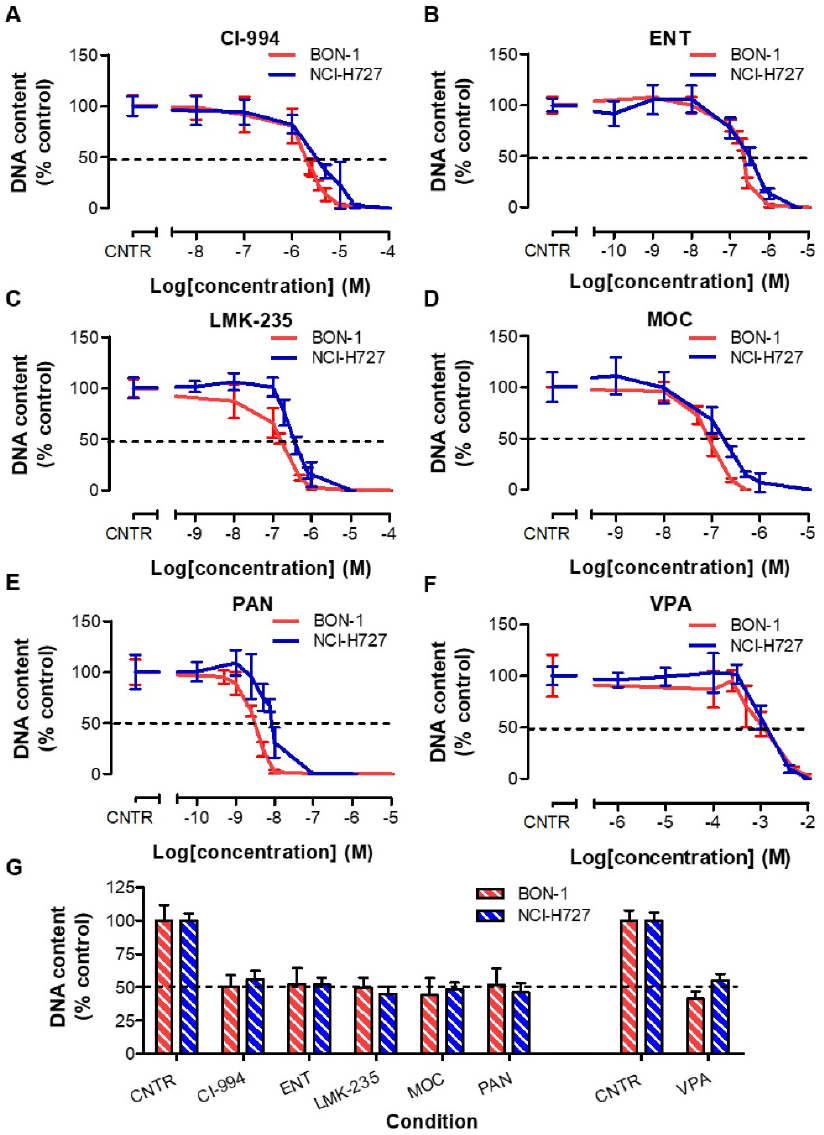
Figure 1. ( A – F ) Dose–response curves of six HDACis in BON-1 and NCI-H727 cells, represented in red and blue, respectively. ( G ) In order to include an experiment for further analysis, in which the effects of HDACis on SSTR2 mRNA levels, uptake of [ 111 In]In-DOTATATE and radiosensitivity were evaluated, a proper reduction in DNA amount (i.e., approximately 50%) was confirmed as the internal control for each experiment. As HDACis were either dissolved in 40% DMSO or sterile aquadest, two vehicle ‐ controls were included.